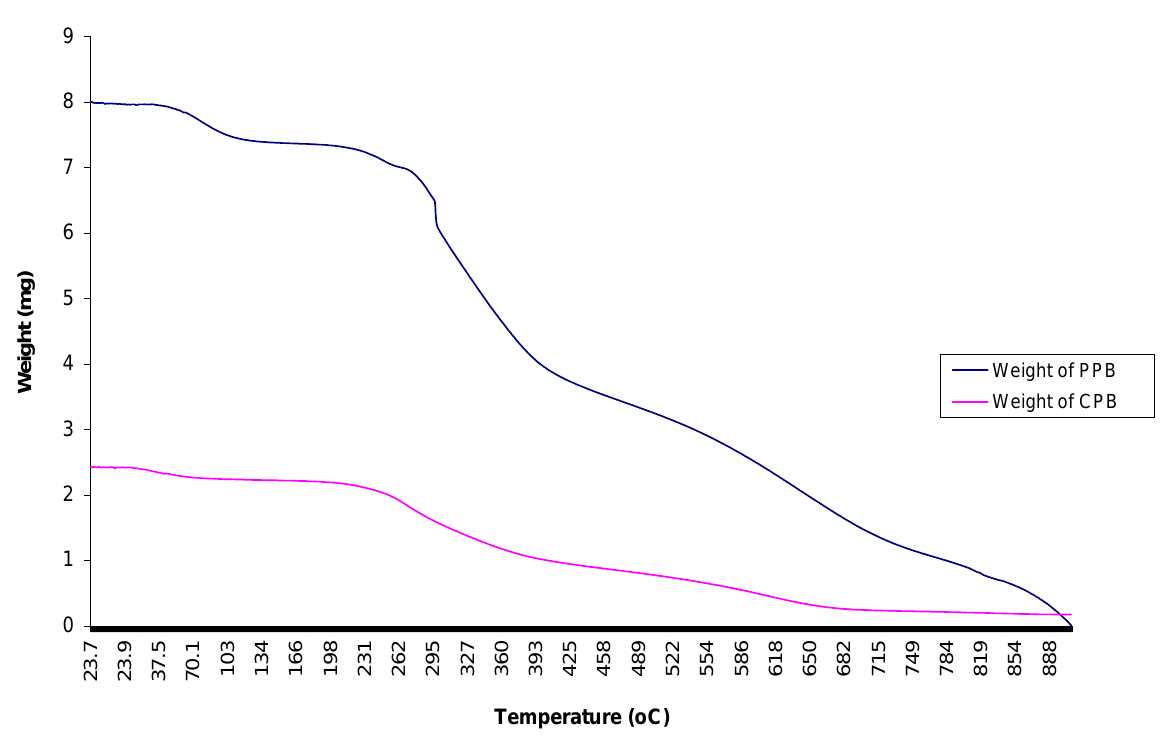
Figure 7. Thioglycolic acid (TGA) curve showing the pyrolysis of purified bioflocculant (CPB and PPB) produced by Brachybacterium sp.